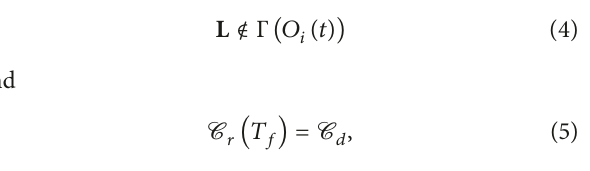
Figure 1: A typical CSC curve starts from 𝑃 1 with